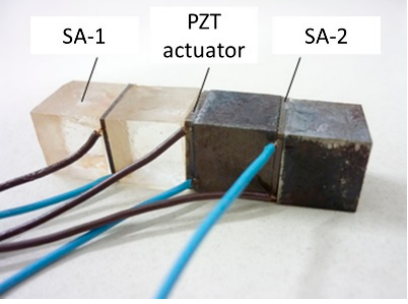
Figure 14. Test member.